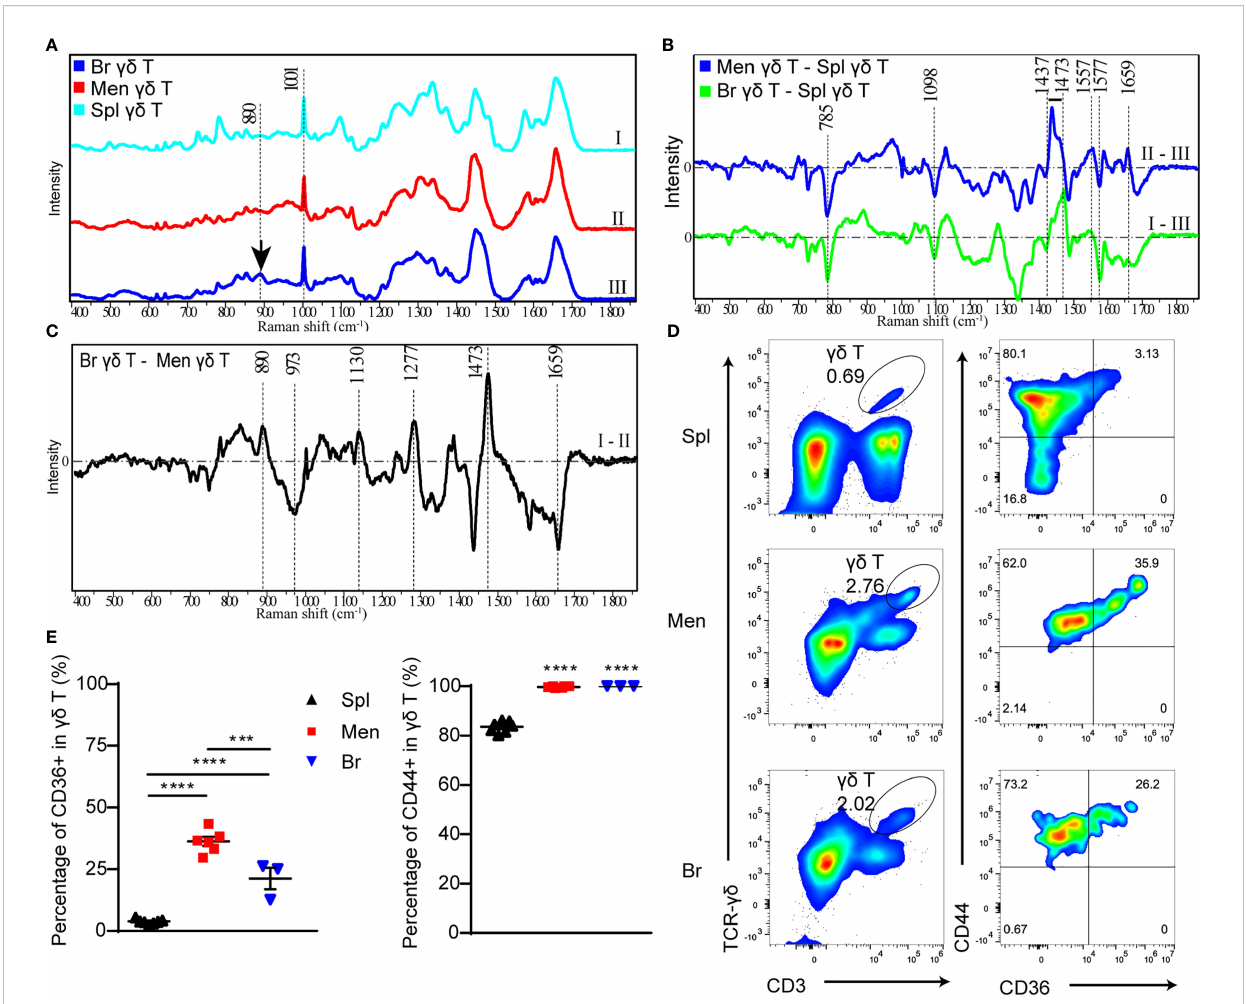
FIGURE 3 The components and functional state of gd T cells are analyzed by Raman spectra and fl ow cytometry respectively. (A) Raman spectra of gd T cells isolated from spleen (I), peri-CMBs brain parenchyma (II) and meninges (III) at 5 dpi. (B, C) The differential Raman spectrum of gd T cells in meninges (Men) and spleen (Spl), brain parenchyma (Br) and spleen, brain and meninges. (C) Raman spectra showing characteristic peaks of saturated fatty acids (890cm -1 , 1130cm -1 , 1277cm -1 ) in peri-CMBs cortical tissues at 5 dpi. (D, E) Flow cytometry uncovers the percentages of CD36- or CD44- positive gd T cells from the meninges, peri-CMBs parenchyma and spleen (D) , and statistical analysis shows high expression of CD44 and CD36 in gd T cells from the meninges and peri-CMBs parenchyma compared to those from the spleen (E) . gd T cells are gated on singled, lived, and CD45 + lymph cells. Each sample from 2 to 4 mice; n ≥ 3 samples in each group; *** P <0.001, **** P <0.0001; One-way ANOVA with Tukey ’ s multiple